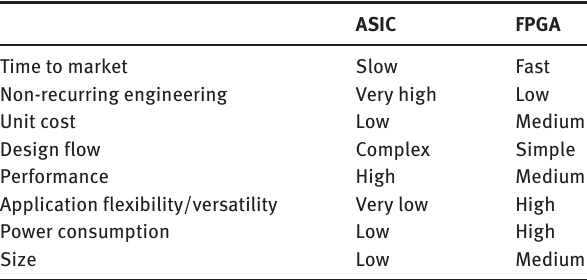
Table 1: Basic features of ASIC and FPGA approaches in